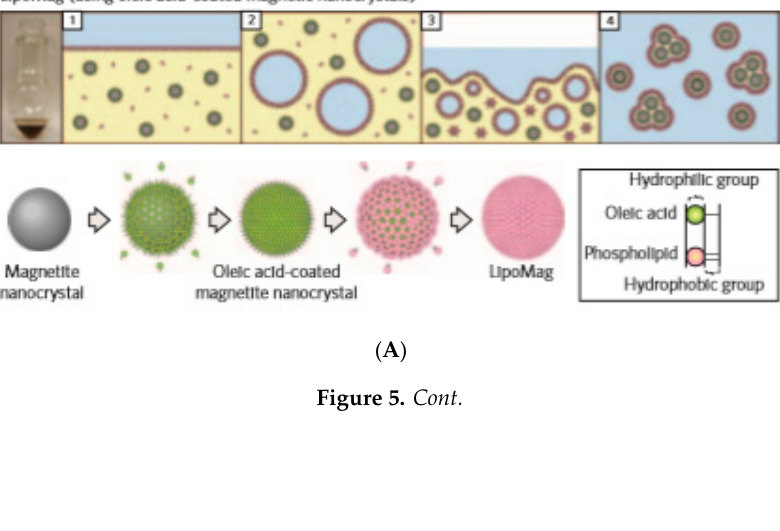
Figure 4. Controlled colloidal assembly of iron oxide nanoparticles from highly volatile